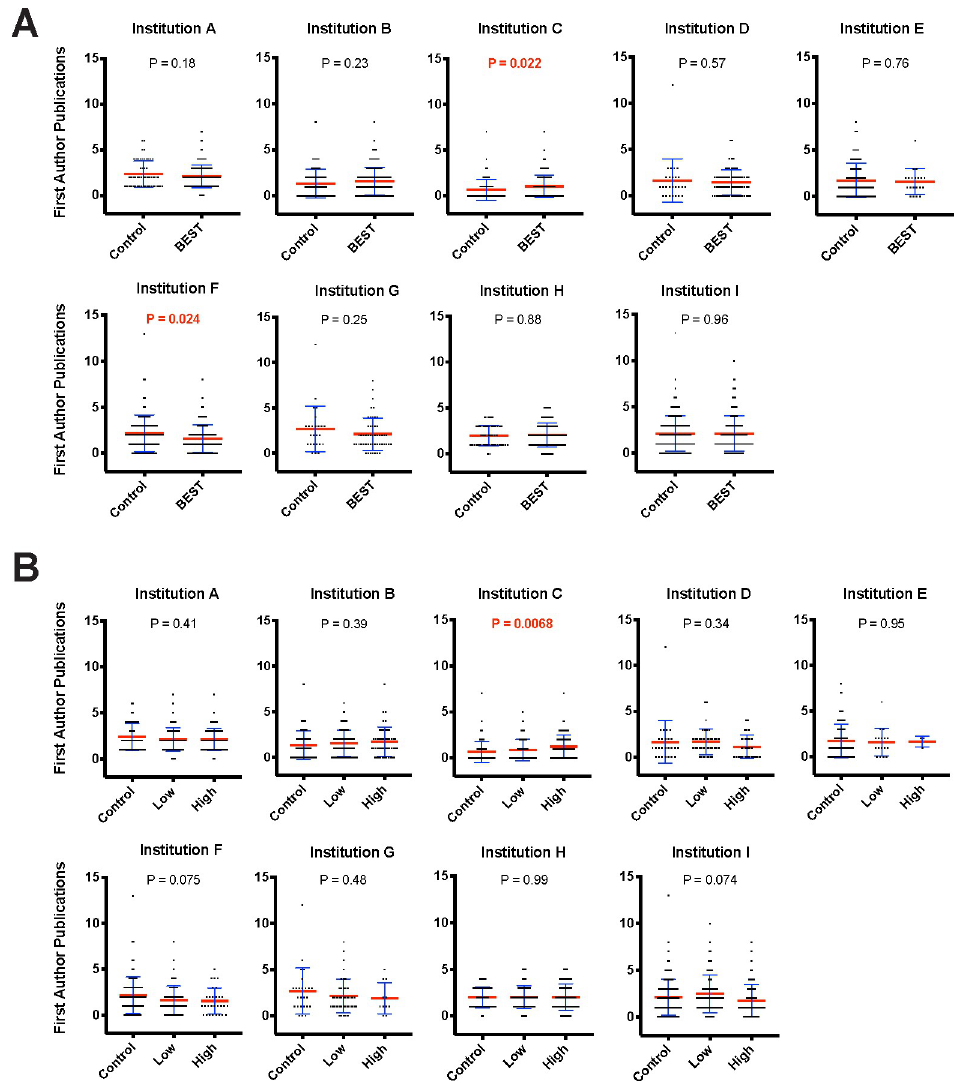
Fig 4. Professional development participation is not associated with a decrease in first-author publication. (A) First-author (including co-first author) publications vs. binary professional development participation. Blue error bars represent standard deviation of the mean. Mean is denoted by a red line. Independent samples t tests (see Table K in S1 Text for statistical test results) were used to compare of control vs. participant first-author publications (significant values of p < 0.05 noted in red). (B) First-author (including co-first author) publications vs. dosage of professional development participation. Blue error bars represent standard deviation of the mean. Mean is denoted by a red line. ANOVA was used to compare the impact of control-, low-, and high-dose participation on first-author publications (significant values of p < 0.05 noted in red). All data sets are available at https://osf.io/qy3pa/ (permanent DOI: